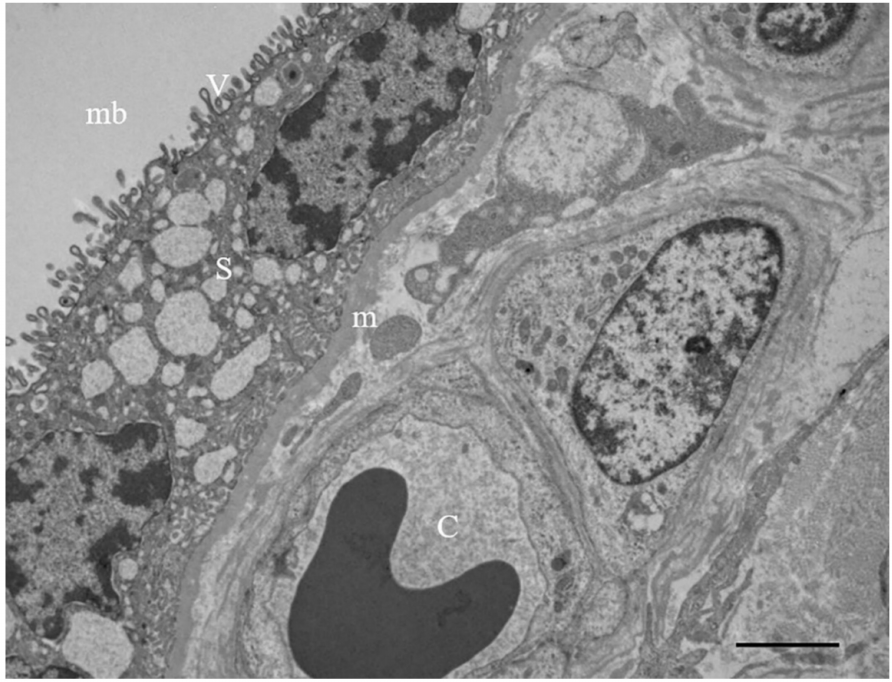
Figure 2. Microphotography of an ultrathin sections of a terminal villus in at term placenta, by TEM. Syncytiotrophoblast (S), covered by microvilli (v), is a continuous and uninterrupted multinuclear surface with the absence of cellular borders. It is separated from the stromal connective tissue by a basement membrane (m). fetal capillary (C); maternal blood (mb). Bar = 2 µ